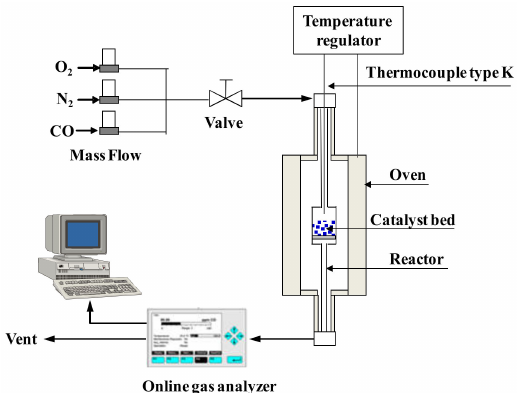
Figure 2. Experimental setup used for the catalytic tests carried out with the di ff erent binary metal oxide